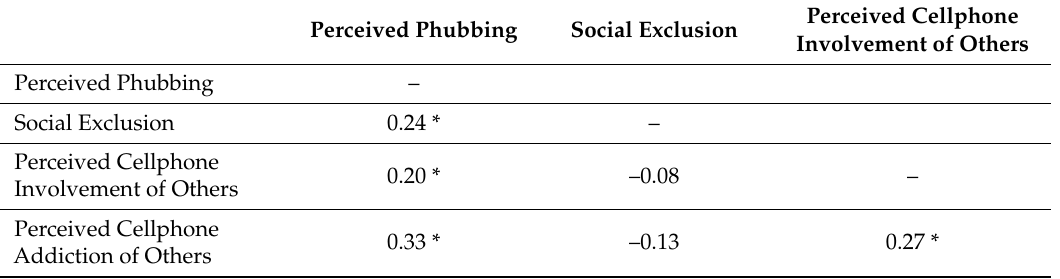
Table 1. Correlation Coe ffi